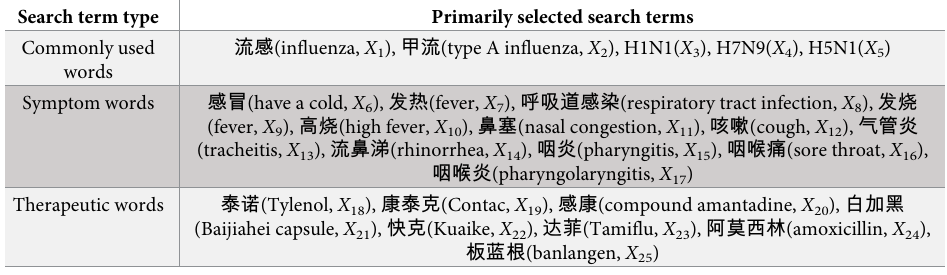
Table 1. Search terms primarily selected in this study.